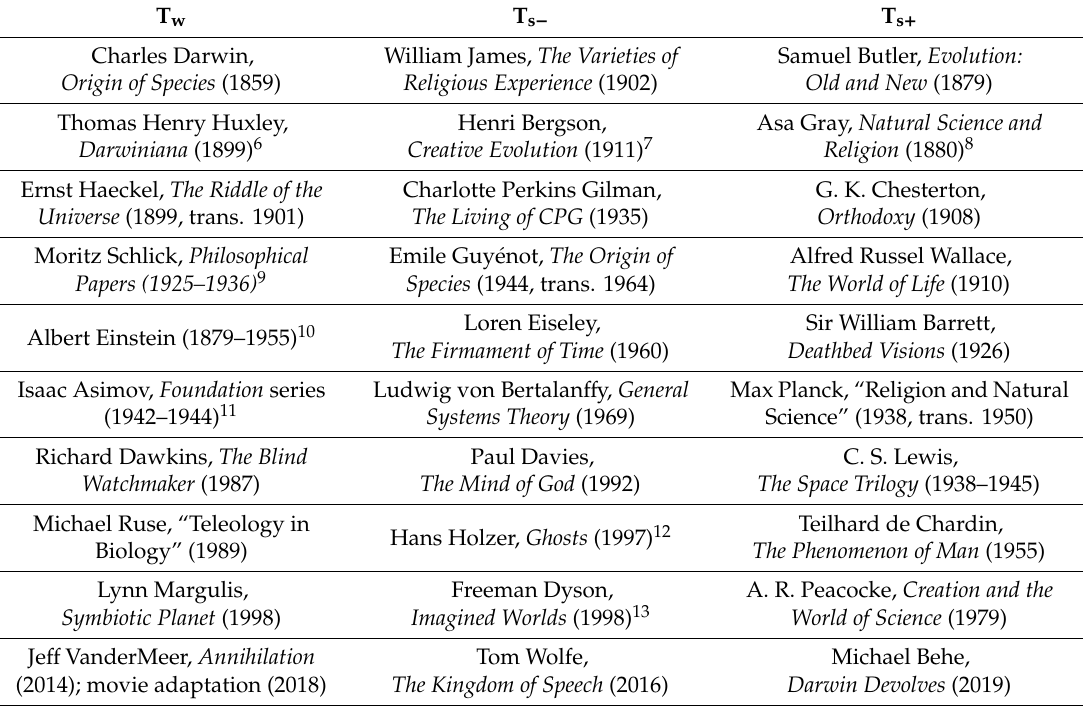
Table A1. A Table of Teleology from Darwin to Present: Selected Scientific, Philosophical, and